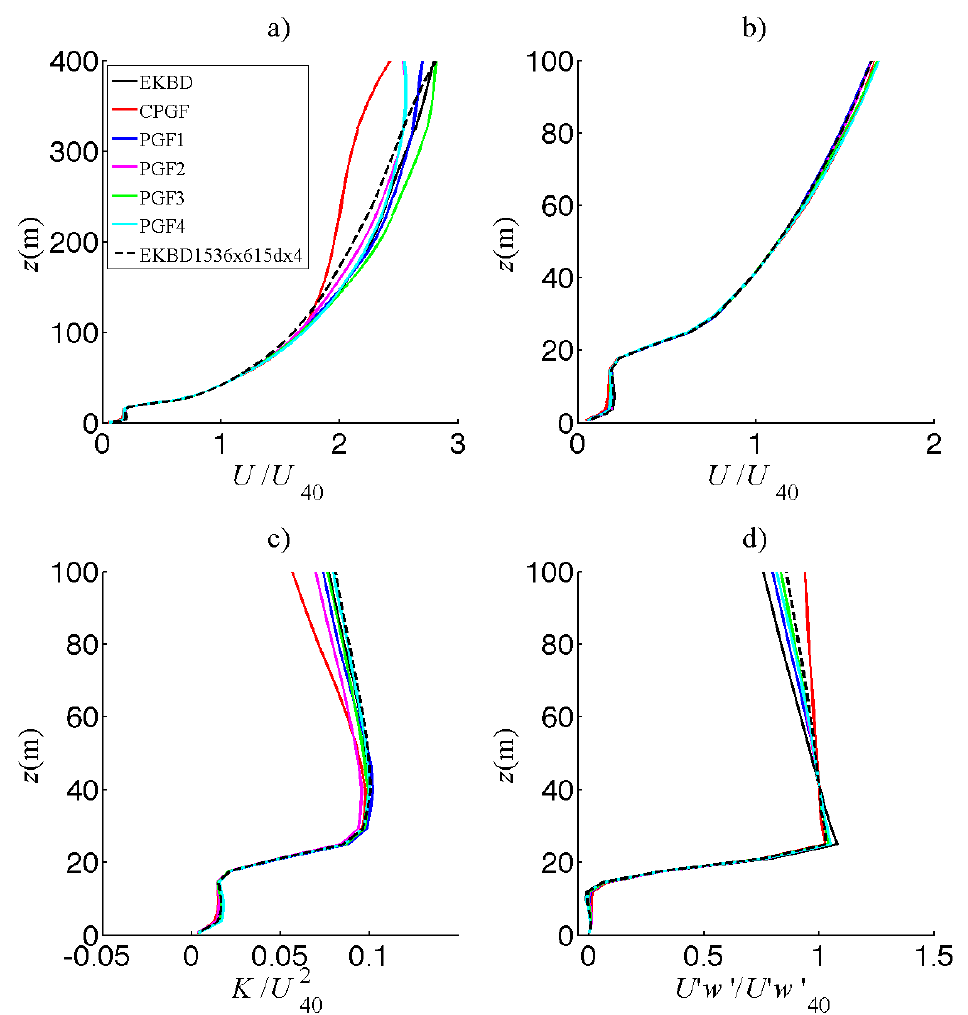
Figure 10. Vertical profiles of normalized turbulent statistics for the canopy-flow simulations (512 m × 512 m × 615 m): ( a ) Mean streamwise velocity up to 400 m; ( b ) mean streamwise velocity up to 100 m; ( c ) turbulent kinetic energy up to 100 m; ( d ) momentum flux up to 100 m. U 40 and U ’ w ’ 40 are the horizontal wind velocity and momentum flux at z = 40 m.